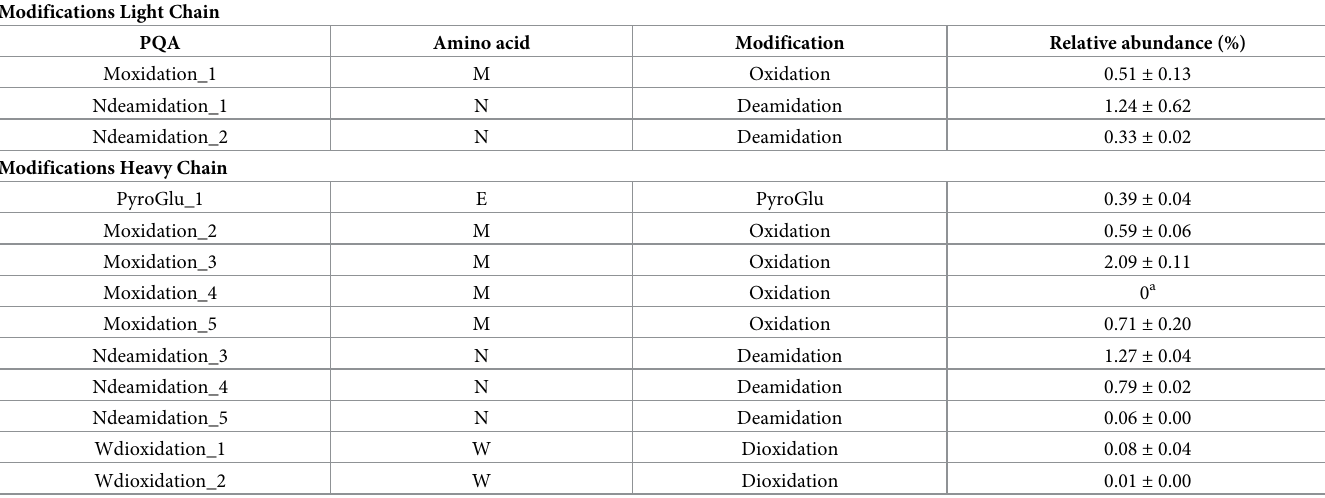
PQA relative abundances are represented as average ± standard deviation. a This PQA was detected only prior to the sample preparation